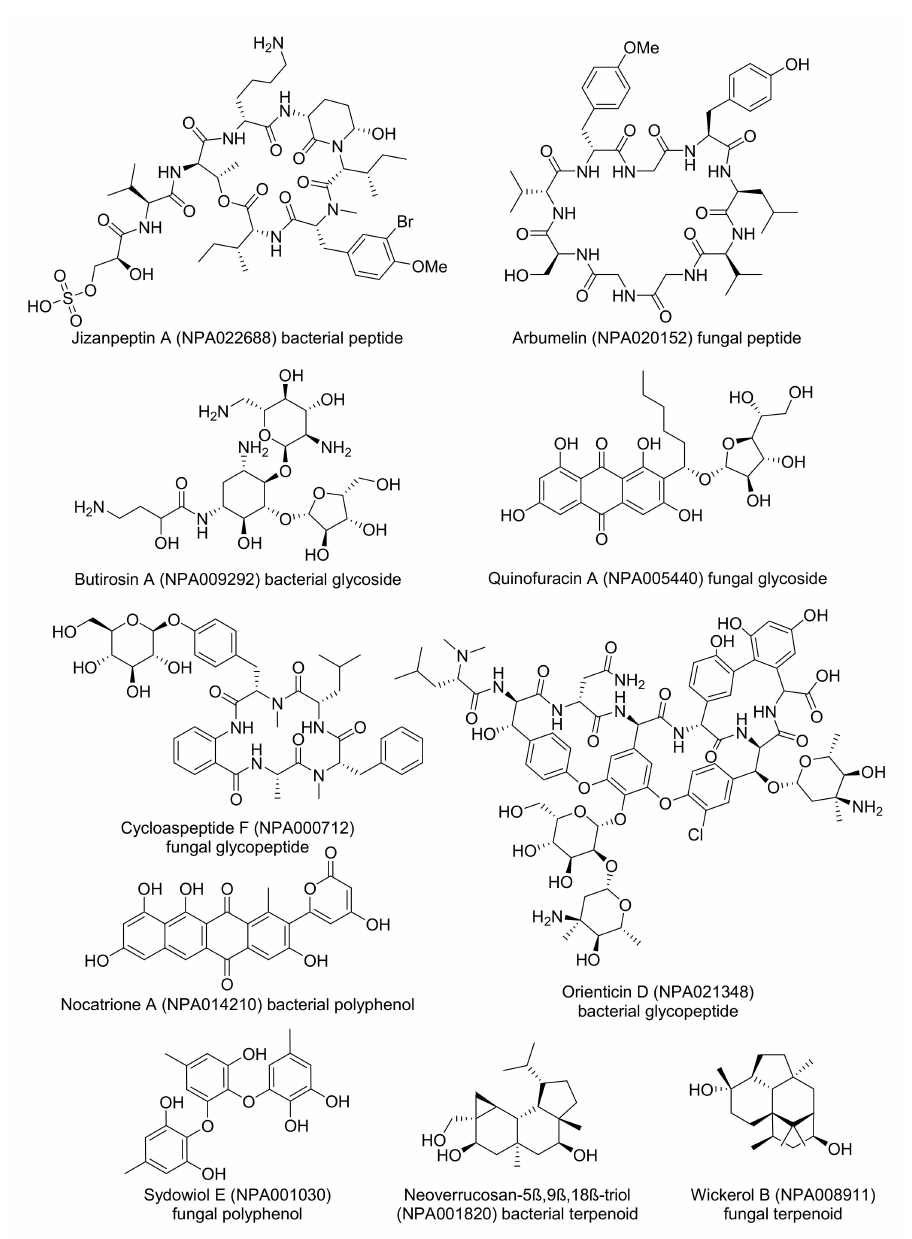
Figure 2. The structural formula of natural product examples selected from the TMAPs in Figure